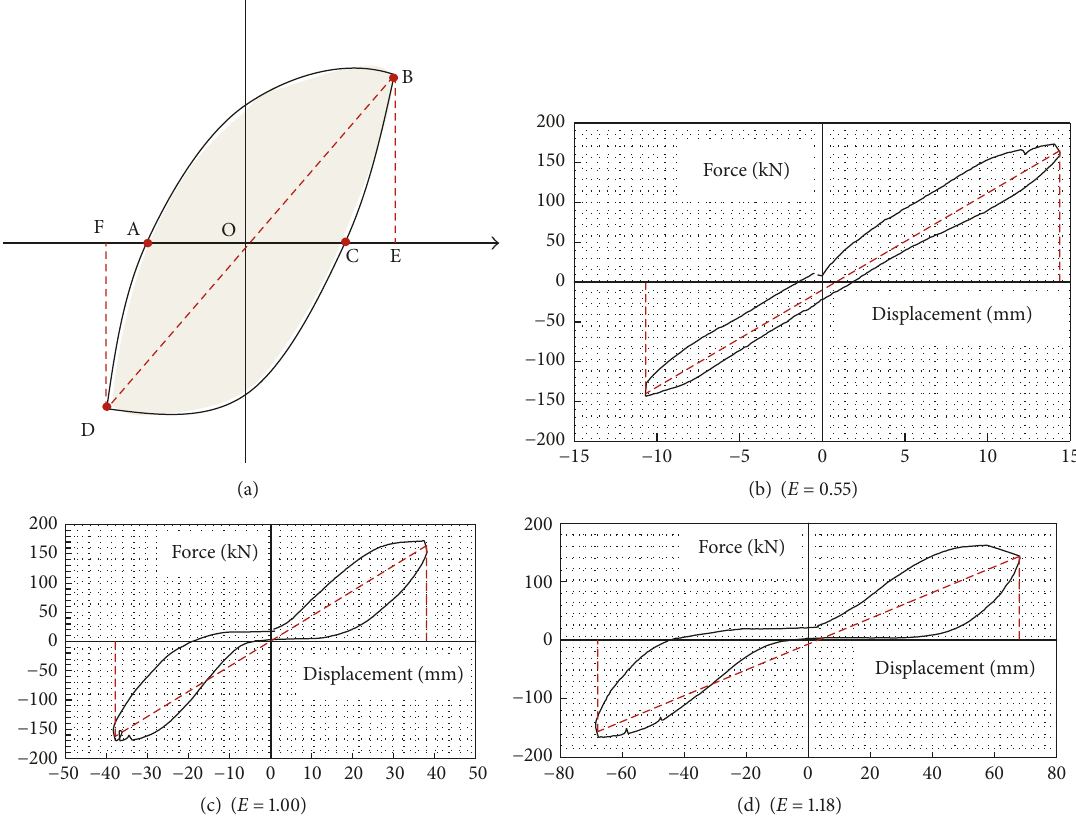
Figure 15: Schematic of dissipative coefficient (a) and the corresponding results in cycle of specimen 1TB2.